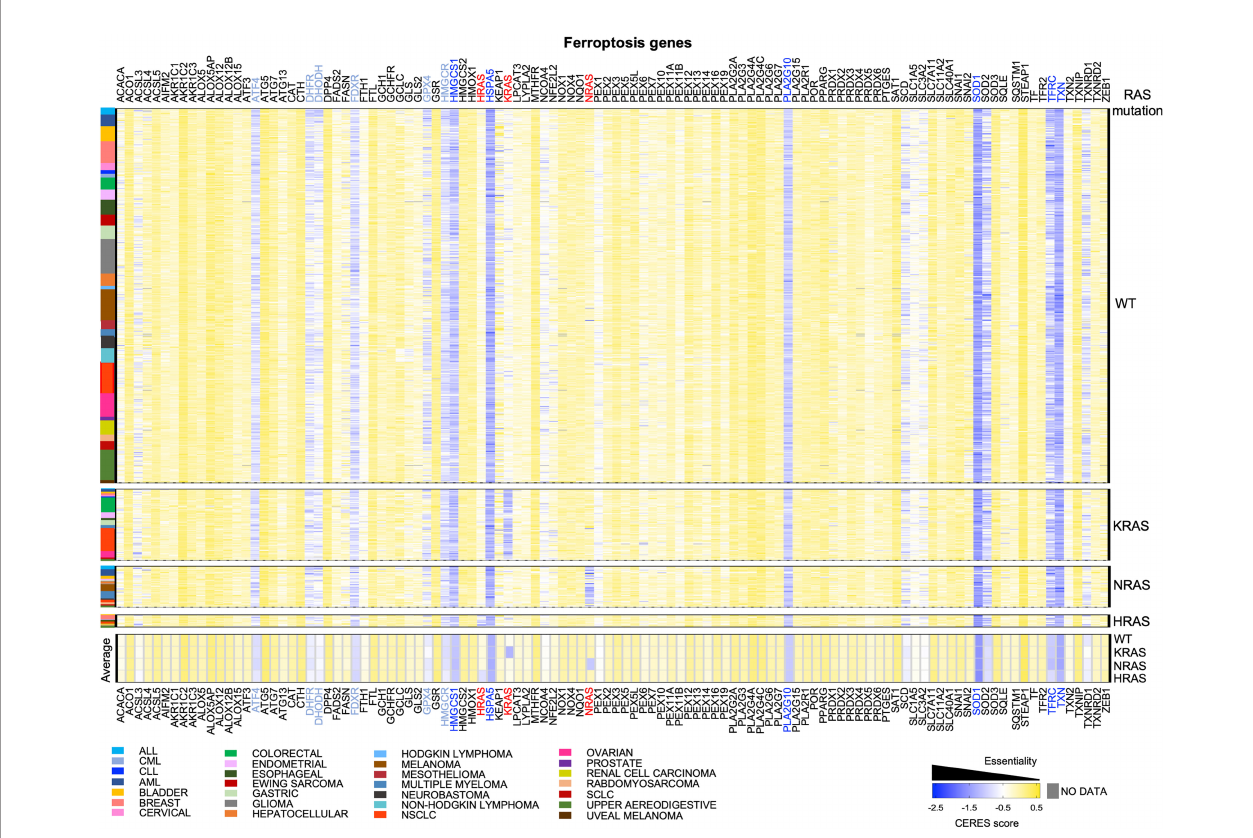
FIGURE 1 | CRISPR knock-out screening from DepMap to identify dependencies on ferroptosis genes in RAS-WT and RAS-MUT cancer cells. The heatmap shows the median CERES dependency (DepMap_21Q3_Public,_CERES) from https://depmap.org/portal/ for the indicated ferroptosis genes (x axes) in the indicated type of cancer cell lines (y axis). The CERES score de fi nes whether a given human cancer cell line is dependent on a given gene: a gene with CERES score of 0 or greater is considered non-essential, whereas a score lower than -0.5 indicates a likely dependency, with -1 indicating all common essential genes. Median CERES score was calculated for each lineage_2 parameter reported in the color legend. Cells were grouped according to the absence (RAS-WT) or the presence of mutations in of KRAS, NRAS, HRAS mutations. The bottom part of the heatmap displays the median CERES score for all the cancer cells of the indicated genotype. RAS genes are indicated in red, genes having an overall median CERES score of -1 or lower are indicated in dark blue and genes with a score between -0.8 and -0.9 are reported in light